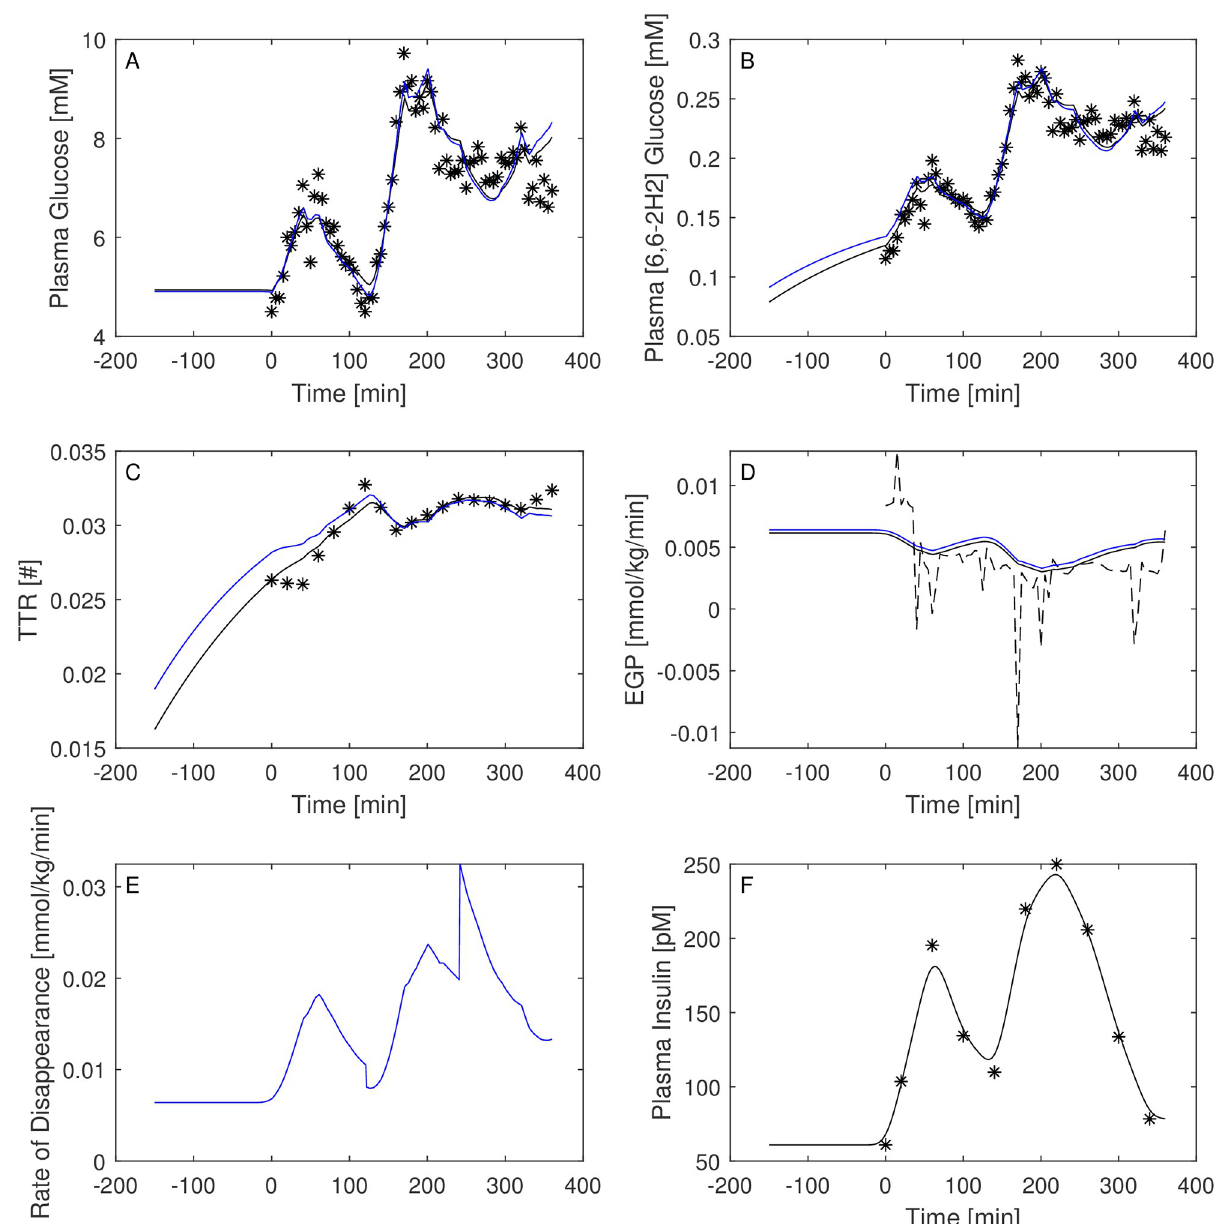
Fig 6. Predictions for Subject 4. Observed (asterisks) and predicted (line) variables over time (IGT subject). EGP: Endogenous Glucose Production; TTR: Tracer to Tracee ratio. Plasma glucose concentration (Panel A); Plasma [6, 6-2H2]glucose (Panel B); TTR (Panel C); EGP (Panel D), dashed line is the predicted EGP with the Steele model; Rate of disappearance (panel E); Plasma Insulin concentrations (Panel F). All the observed points refer to data measured on day 2. Plasma glucose concentrations (panel A) are derived from the glucose intra-venous infusion to match plasma glucose observations from the OGTTs of day 1. Black lines in panels A, B, C, D and E are model predictions from WLS estimation procedure; blue lines derive from the estimation approach which uses autocorrelated errors.